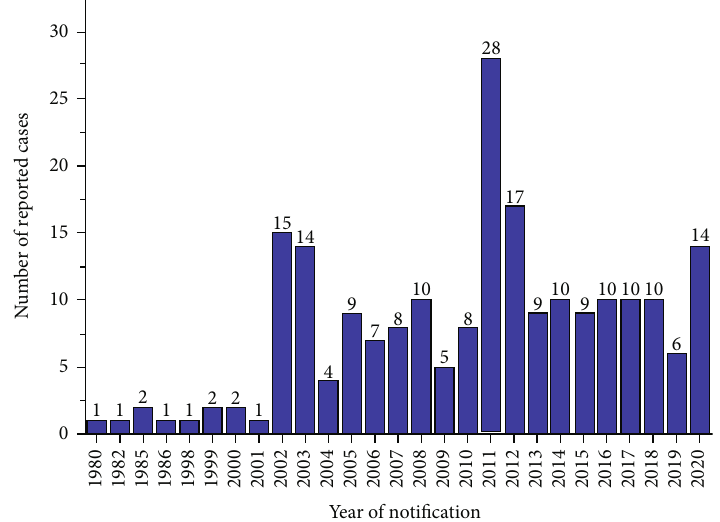
Figure 3: Number of noti fi cation reports per year for tomato adulteration/fraud within the period 1980 to Table 2: Categories of hazards for chilli pepper and tomato